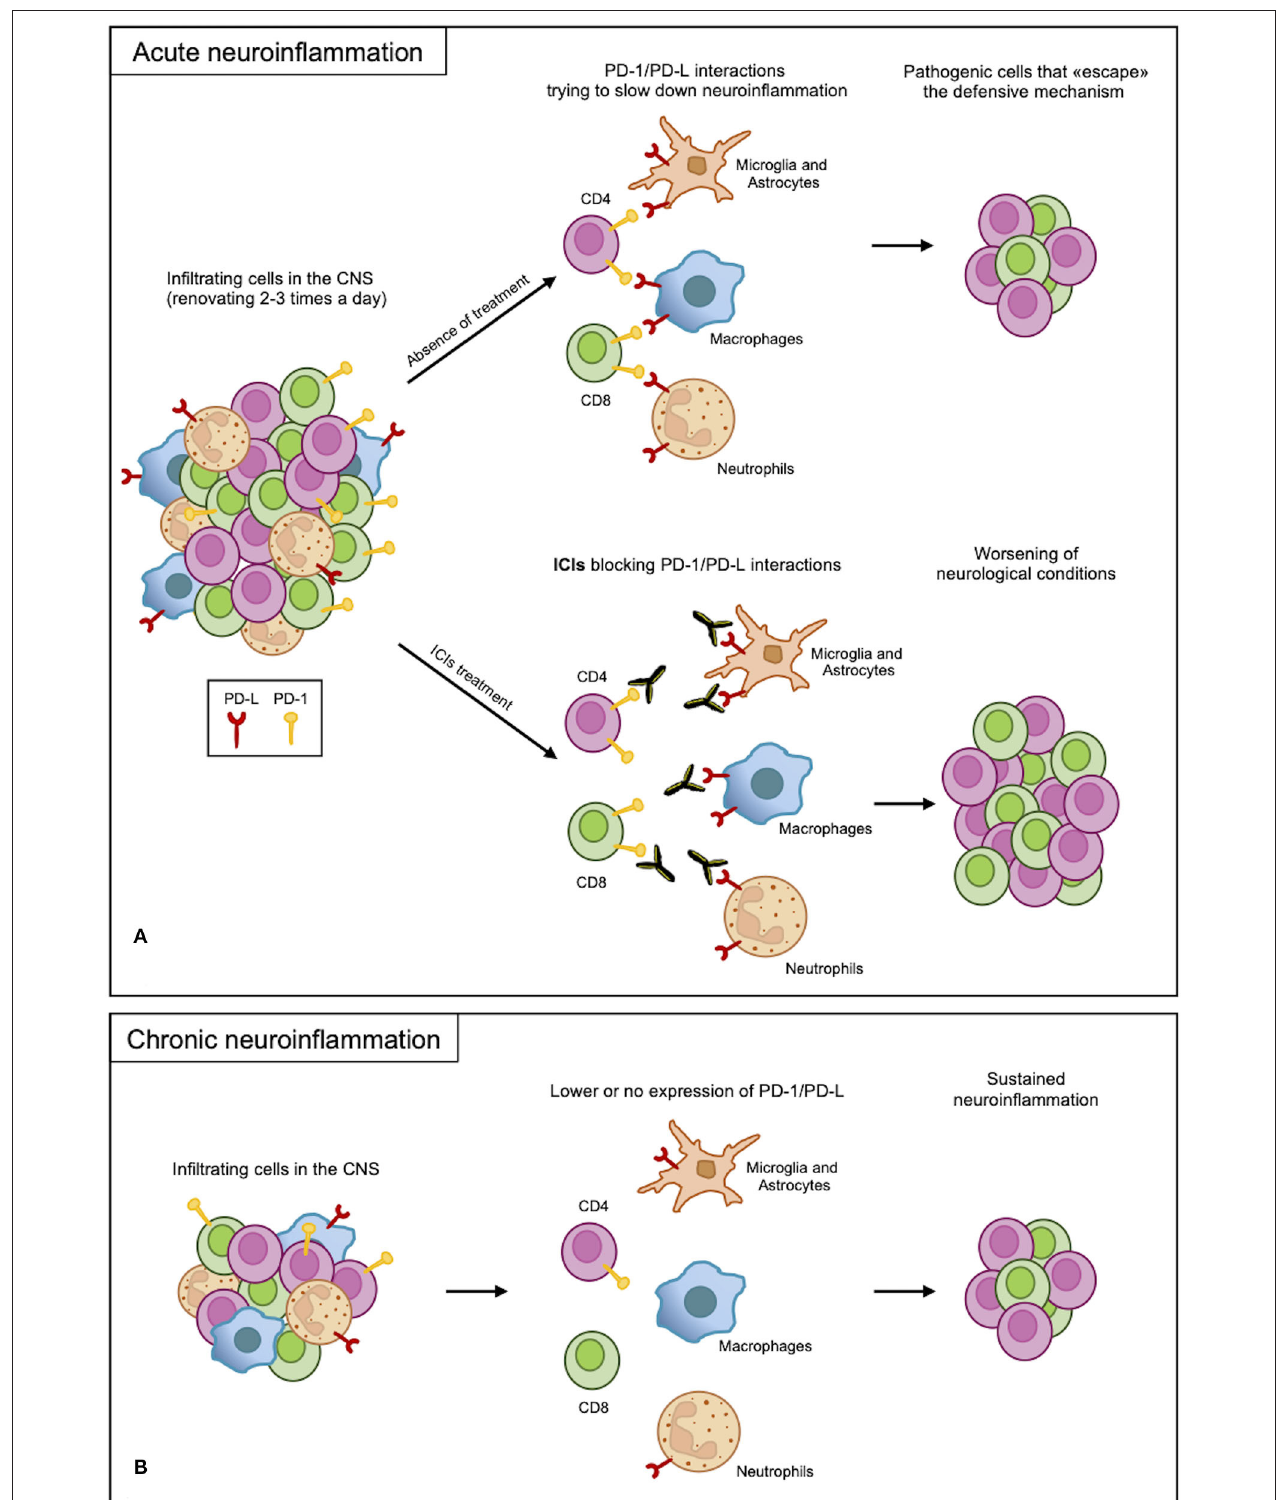
FIGURE 2 | PD-1/PD-L axis in neuroinflammation. (A) In acute neuroinflammation, CNS infiltrates are renewed 2-3 times a day. Infiltrating myeloid and resident cells expressing PD-Ls attempt to slow down the inflammatory process through interactions with PD-1 expressed on the lymphoid cells. Due to an overabundance of cells, some pathogenic cells escape this protective mechanism, causing damage. However, blocking PD-1/PD-L interactions with ICI treatments remove this defense, leading to the worsening of the inflammation. (B) In chronic inflammation, the PD-1/PD-L axis may not function properly as a result of low or no expression of the receptor and ligand; therefore, the sustained inflammation